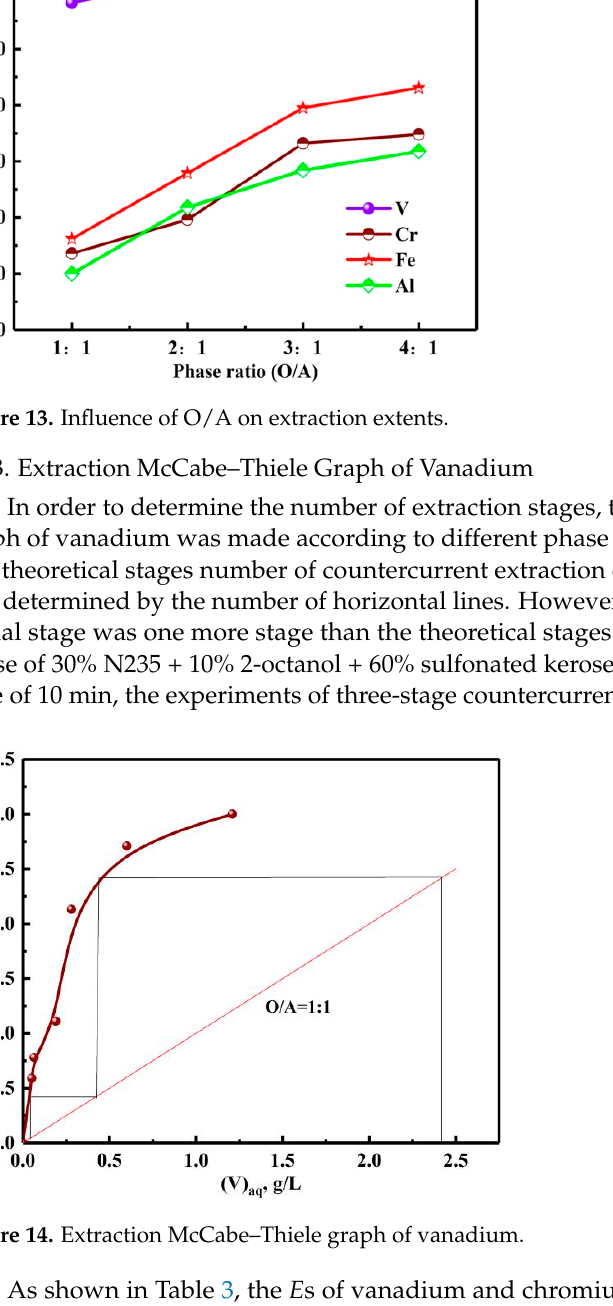
Figure 14. Extraction McCabe–Thiele graph of vanadium.